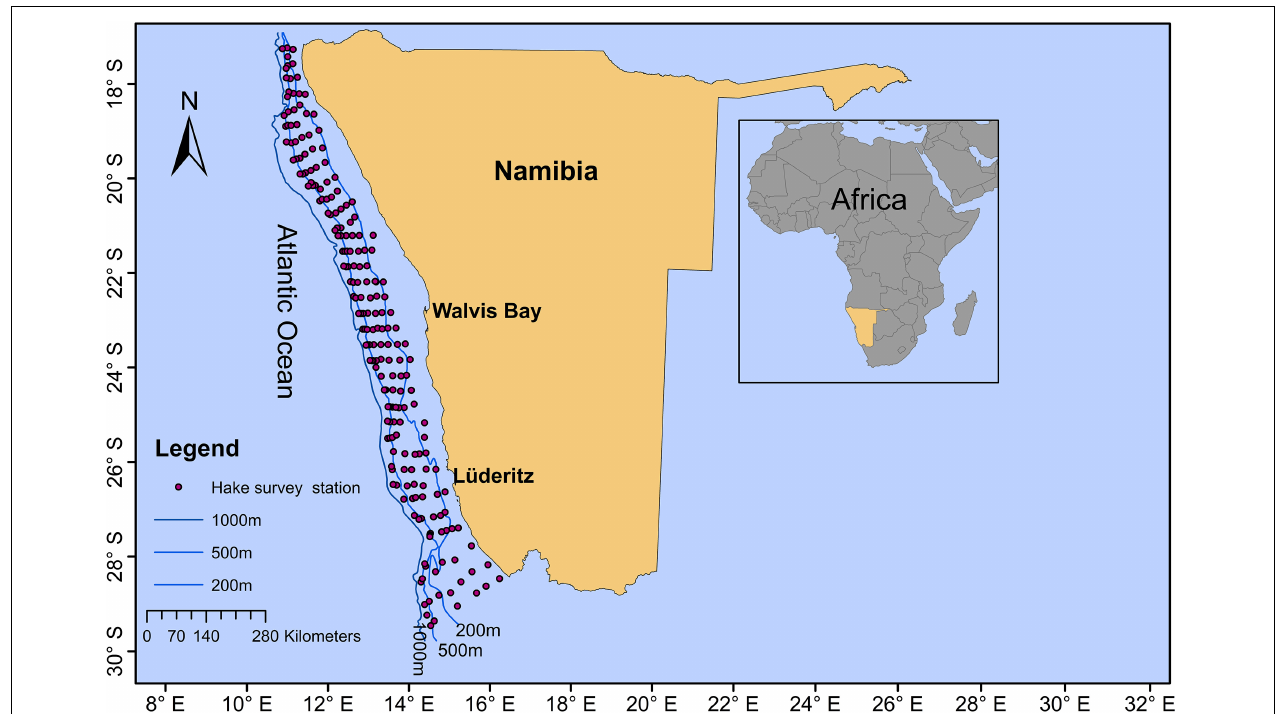
FIGURE 1 | Sampling area and demersal (hake) summer survey stations (red dots) from which samples were selected for the Merluccius paradoxus otolith chronology along the Namibian coast. Bottom depth contours (200, 500, and 1,000 m) are indicated by blue lines.